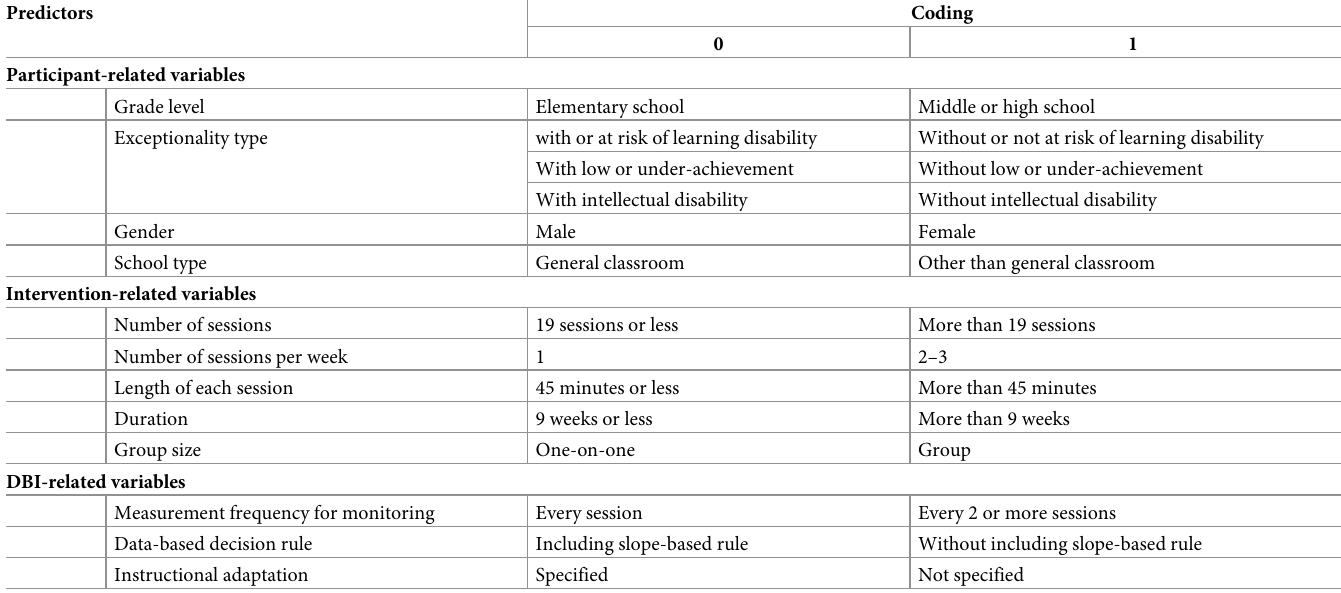
Table 10. Coding system for the Level-2